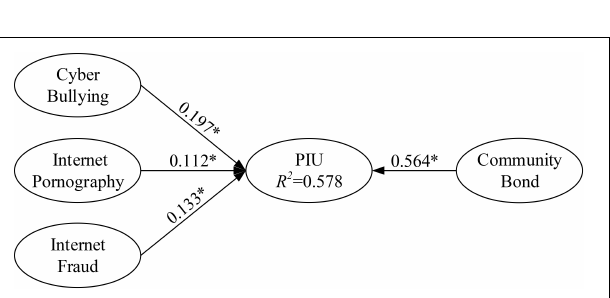
FIGURE 3 | Path coefficients for the research model (including moderator main